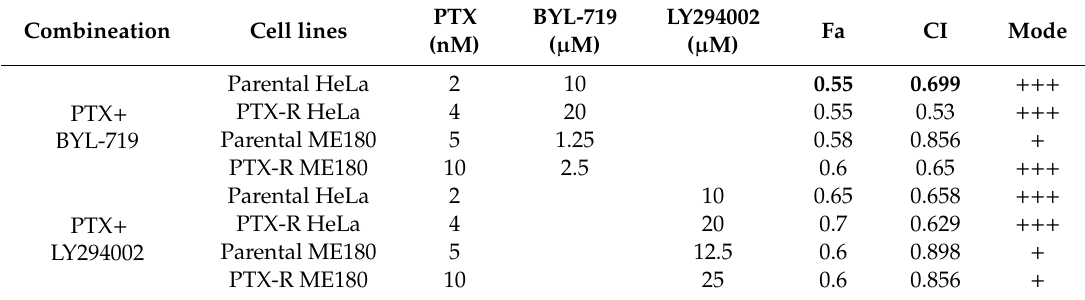
Table 1. Experimental CI Values for BYL-719 or LY294002 Combination with Paclitaxel.